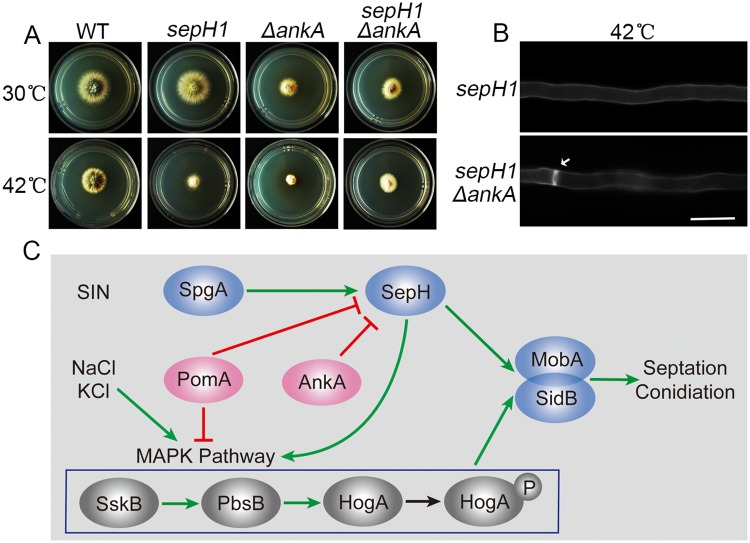
Suppressed sepH1 defects by deletion AnkA in septation and a cross-link working model between the SIN and the MAPK.(A) Colony morphologies of the wild type (TN02A7), sepH1, ΔankA sepH1 and ΔankA strains cultured on YUU at 30 or 42 °C for 2 days. (B) Septa comparison in hyphal cells stained with CFW in the indicated strains cultured in liquid rich media YUU at 42 °C for 20 h. Arrows indicate the locations of septa. Bars, 10 μm. (C) A schematic model for the MAPK and the SIN-SepH-MobA/SidB pathways regulated by PomA-AnkA regulation during septation and conidiation. Green arrows indicate induce and labels for red lines indicate inhibit.